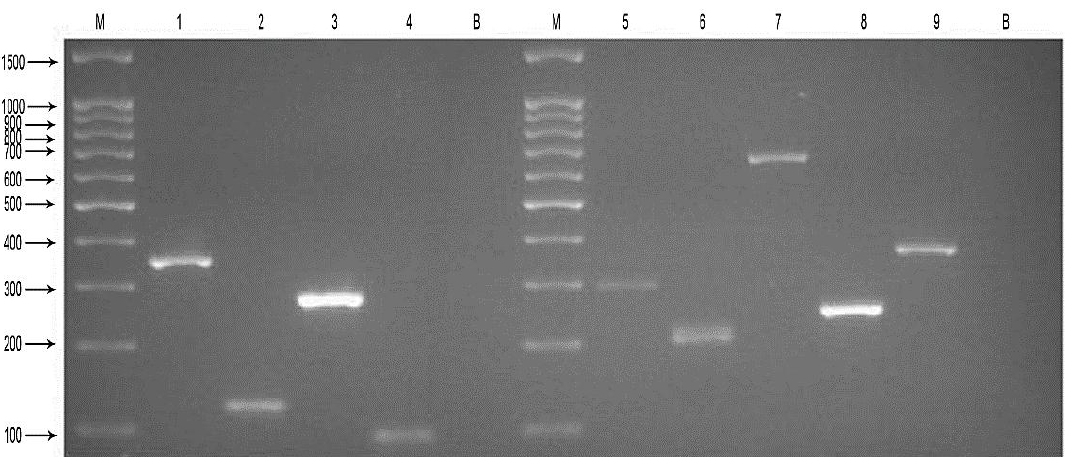
Figure 1. Results of the two mPCR reactions for nine target pathogens. Agarose gel electrophoresis showing the results of the four-plex PCR amplification and five-plex PCR amplification. Each DNA sample was successfully amplified and lanes are as follows: M, DNA Marker 100; 1, S. pneumoniae 350 bp; 2, M. catarrhalis 140 bp; 3, S. aureus 270 bp; 4, S. pyogenes 93 bp; B, negative control (distilled water); M, DNA Marker 100; 5, H. influenzae 296 bp; 6, M. pneumoniae 209 bp; 7, Legionella spp. 650 bp; 8, P. aeruginosa 249 bp; 9, K. pneumoniae 364 bp; B, negative control (distilled water).